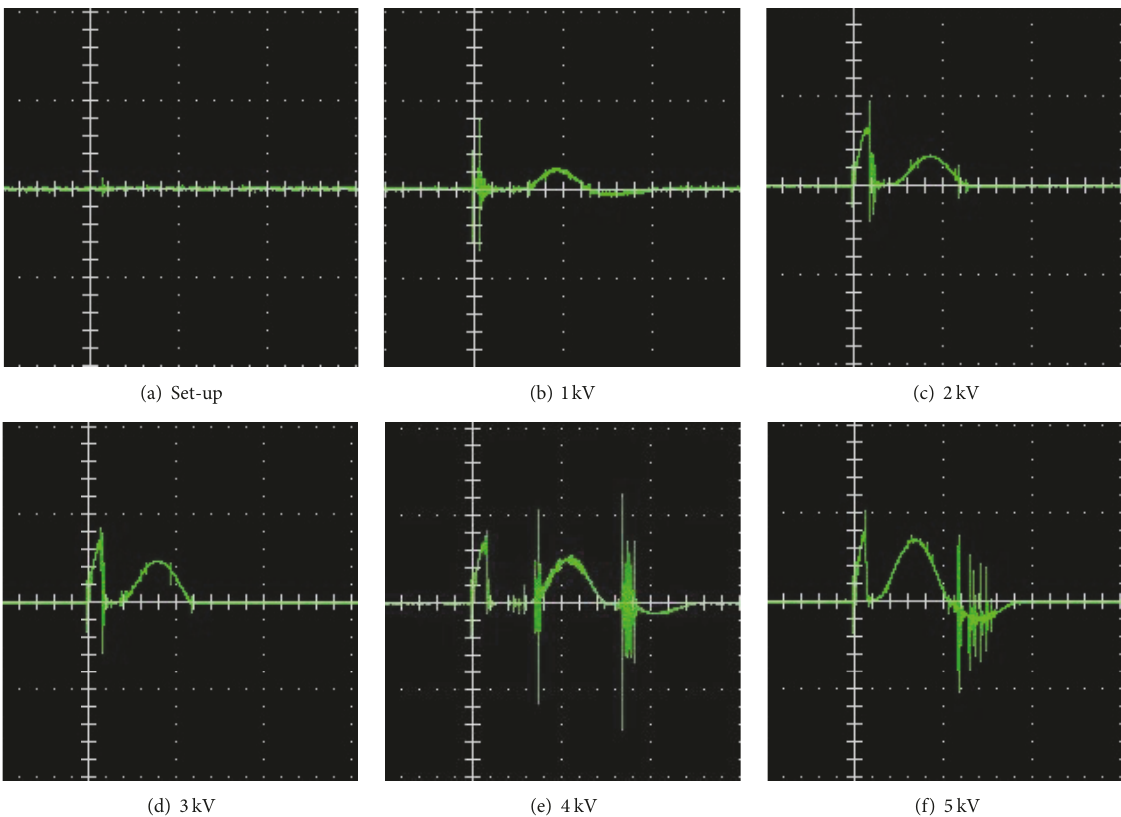
Figure 6: Discharge waveform ( 𝑋 : 200 𝜇 s/div, 𝑌 : 500 mV/div) with a calibration coefficient of 25 kA/mV.